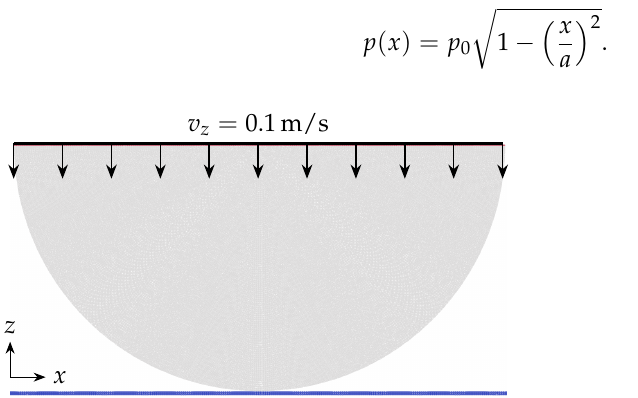
Figure 4. Initial geometry of the Hertzian contact test case where the upper boundary of the cylinder is moving downward with a constant